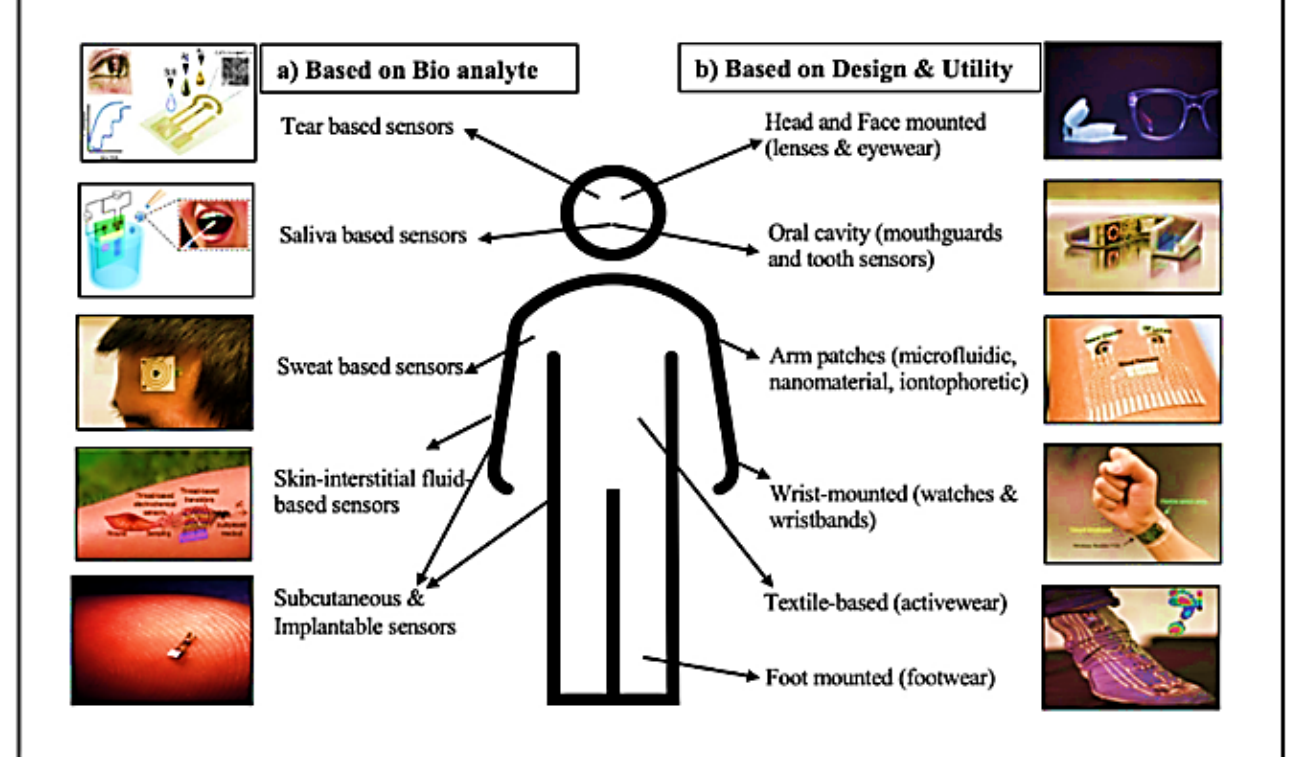
Figure 4. Different wearable biosensor devices are categorized based on: ( a ) bio-analytes and ( b ) design and utility [39].